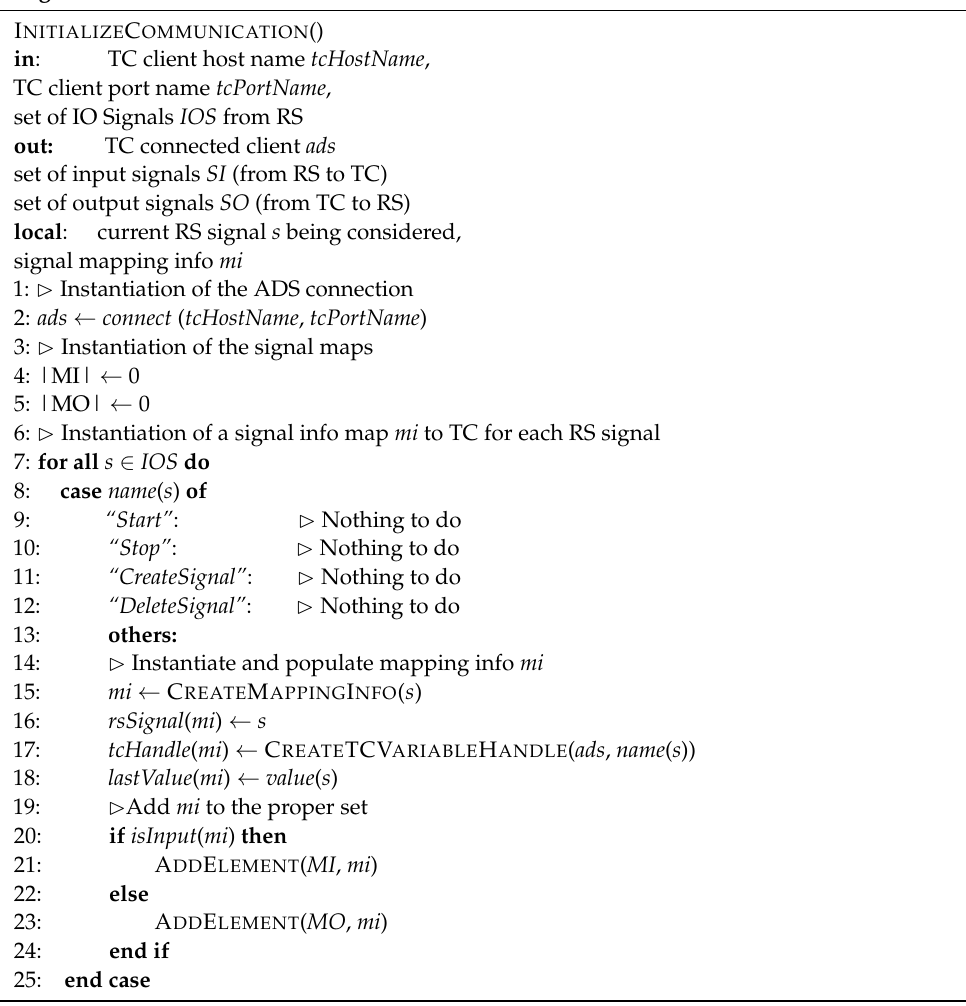
Algorithm 1 Communication